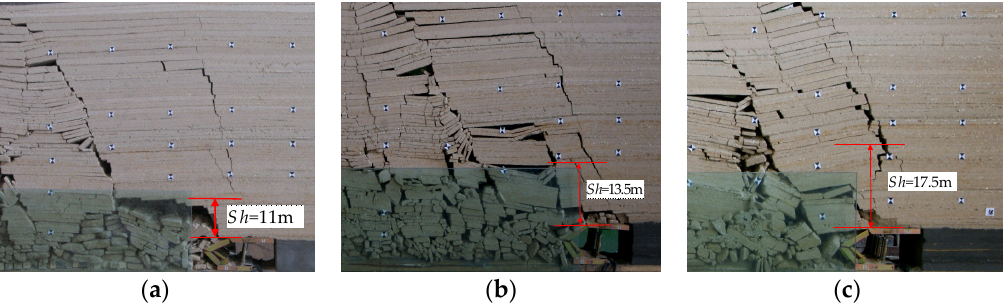
Figure 2. Pictures showing the thickness of EIR with different mining heights: ( a ) the mining height is 4 m; ( b ) the mining height is 5 m; ( c ) the mining height is 6 m.